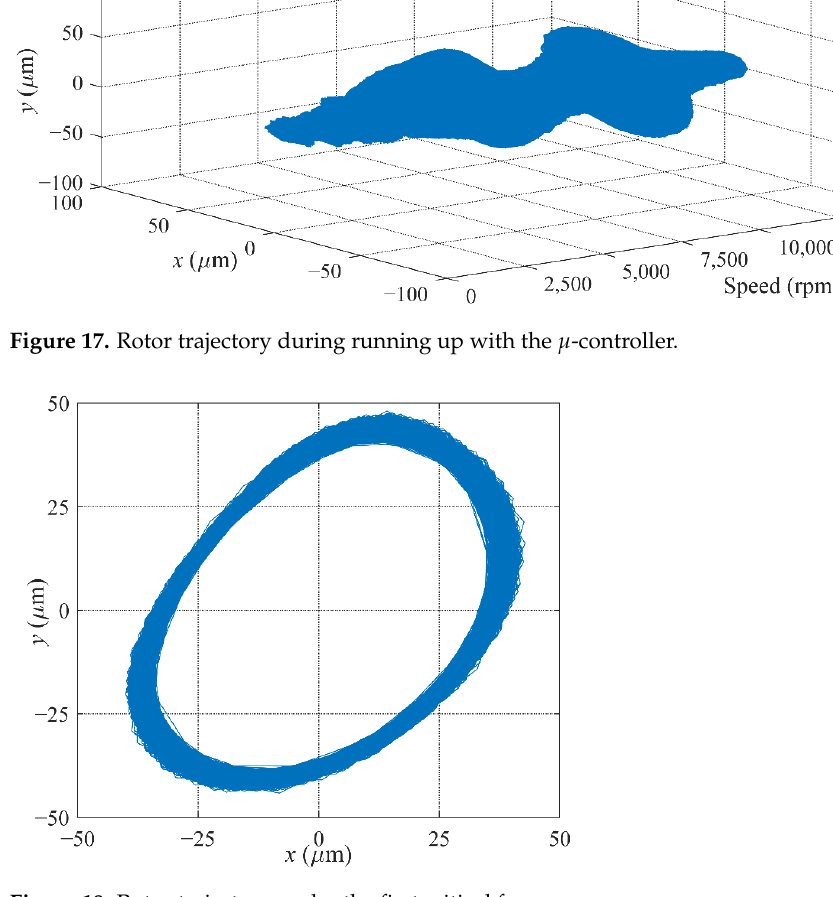
Figure 18. Rotor trajectory under the first critical frequency.